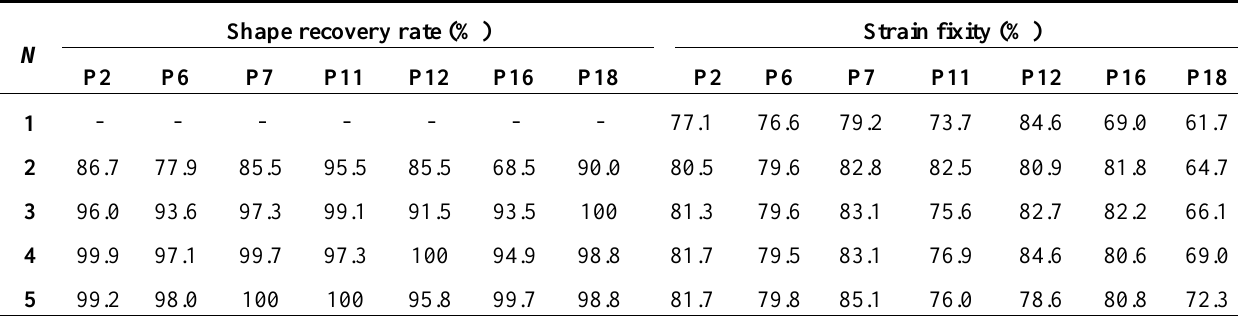
Table 2. Shape recovery rate and strain fixity during the first five thermomechanical cycles ( N = number of cycle) for selected polymers.